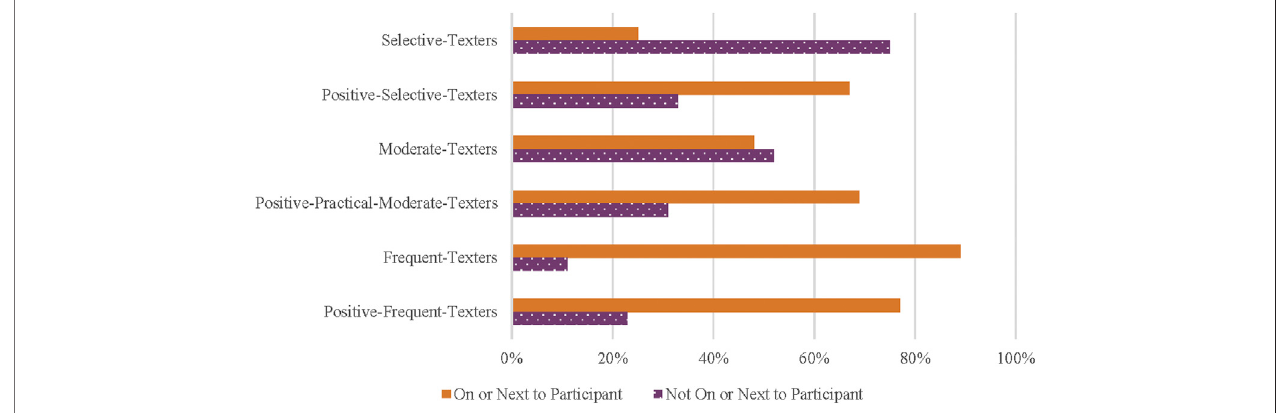
FIGURE 4 | Cell phone location when completing